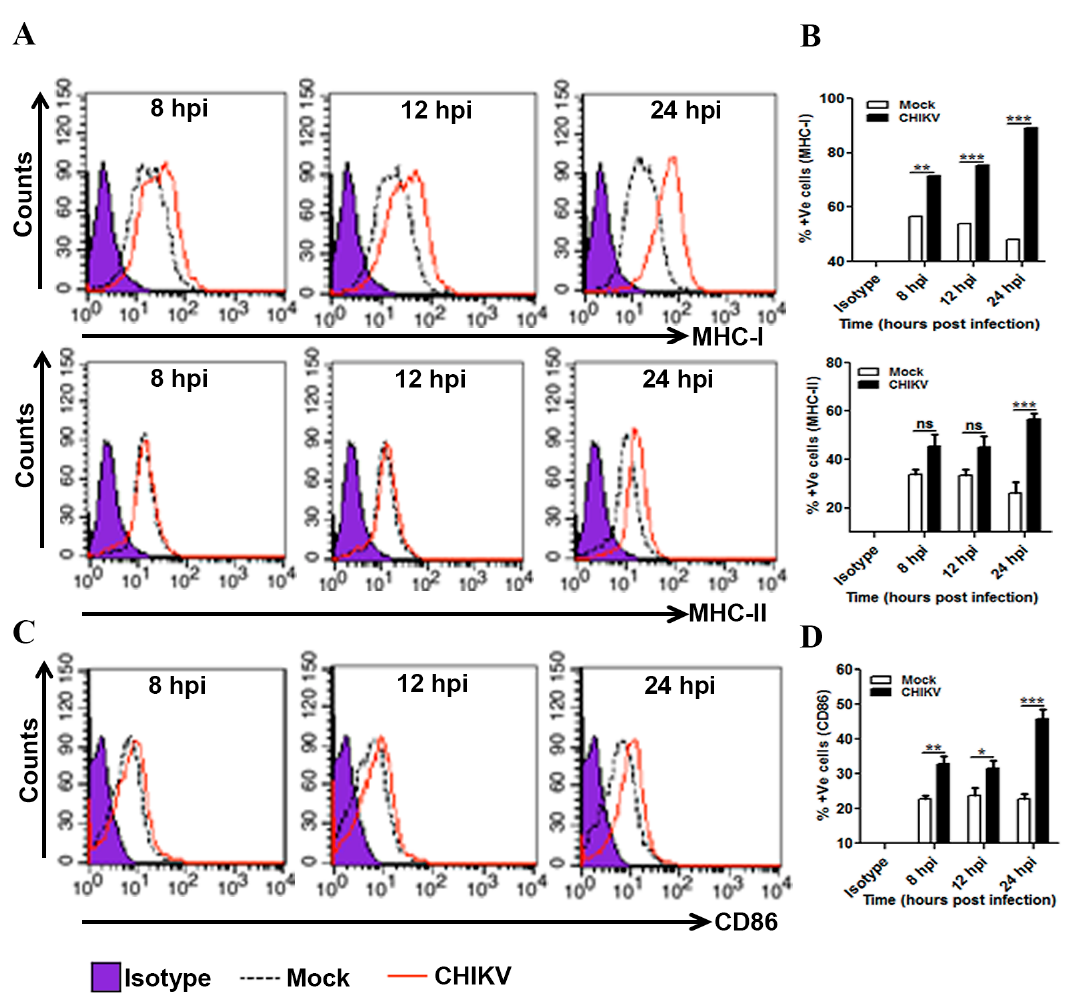
Figure 4. Expression pattern of MHC and co ‐ stimulatory molecules during CHIKV infection in macrophages. CHIKV infected Raw264.7 cells were harvested at different time intervals followed by flow cytometry based analysis. ( A ) MFI representing MHC ‐ I (upper panel) and MHC ‐ II (lower panel) expressions in isotype (purple filled), mock (black dashed line) and CHIKV infected macrophage (red solid line). ( B ) Bar diagram showing percent positive cells for MHC ‐ I (upper panel) and MHC ‐ II (lower panel) in mock (white bar) and CHIKV infected samples (dark bar) at 8, 12 and 24 hpi. ( C ) MFI representing CD86 expression in isotype (purple filled), mock (black dashed line) and CHIKV infected macrophage (red solid line). ( D ) Bar diagram showing percent positive cells for CD86 in mock (white bar) and CHIKV infected samples (dark bar) at 8, 12 and 24 hpi. Data represent Mean ± SEM of at least three independent experiments. p < 0.05 was considered as statistically significant difference between the groups. (ns, non ‐ significant; * p ≤ 0.05; ** p ≤ 0.01; *** p ≤ 0.001).